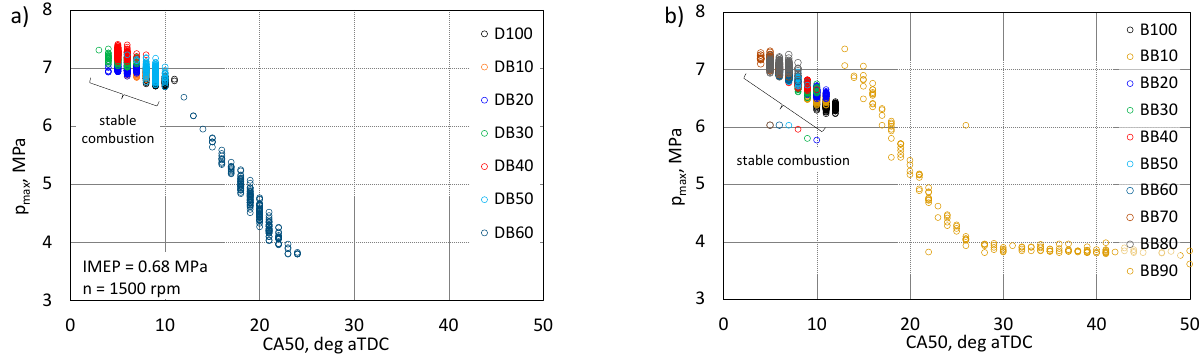
Figure 12. Correlation of peak pressure and CA50 for DB ( a ) and BB ( b ).